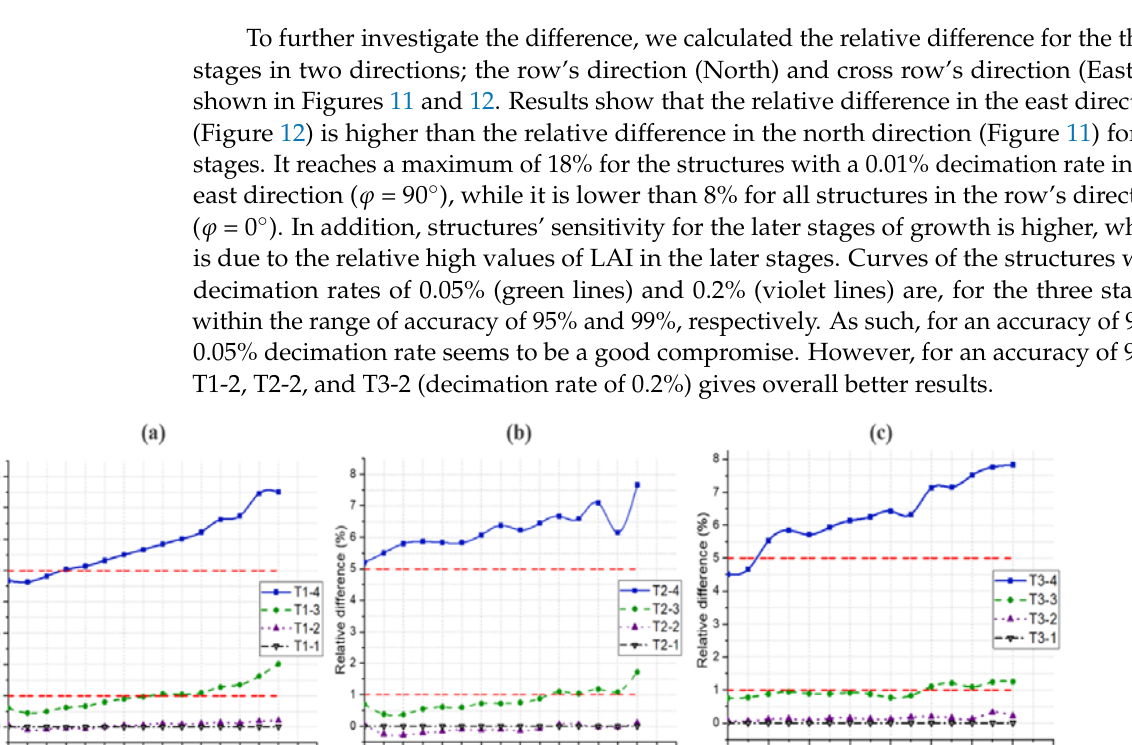
Figure 10. Gap fraction polar contour diagrams for the third stage (25 October 2019).